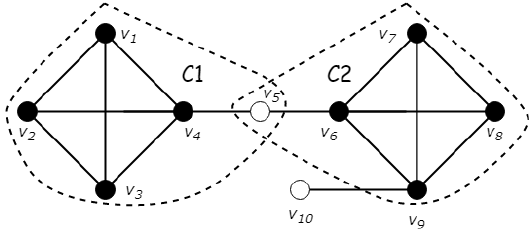
Figure 3. An example